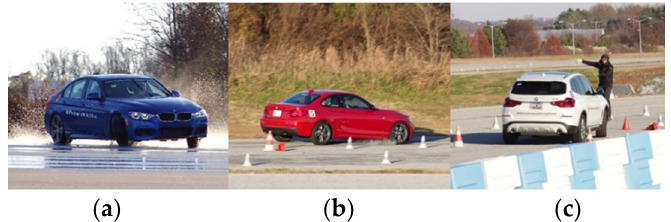
Figure 2. ( a ) A driver learning how to recover from a skid, ( b ) a driver activating the ABS brakes, and ( c ) a driver completing the distraction exercise with an instructor on the track providing